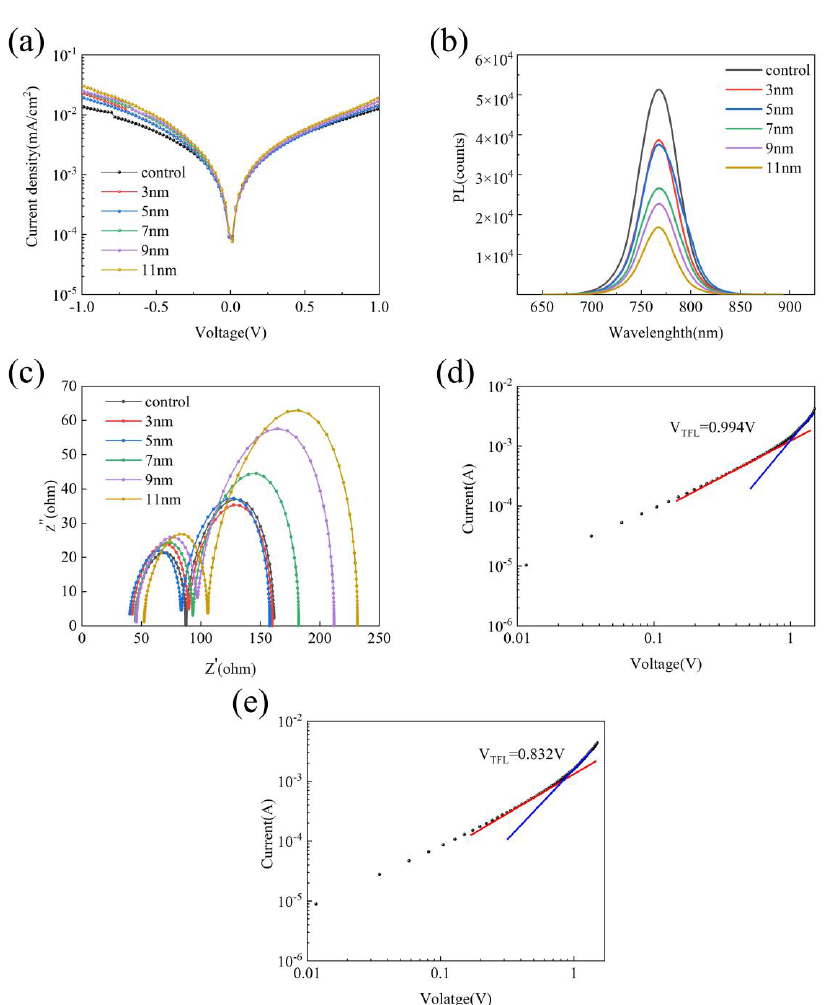
Figure 3. ( a ) Dark current of the FTO / perovskite / carbon structure PSCs with Ag@SiO 2 core-shell nanoparticles with a di ff erent shell thickness. ( b ) PL spectra and ( c ) EIS spectra of PSCs with Ag@SiO 2 core-shell nanoparticles with di ff erent shell thicknesses. ( d ) Current-voltage of FTO / perovskite / carbon structure pristine PSCs. ( e ) Current-voltage of FTO / perovskite / carbon structure PSCs with Ag@SiO 2 core-shell nanoparticles with a 5-nm shell